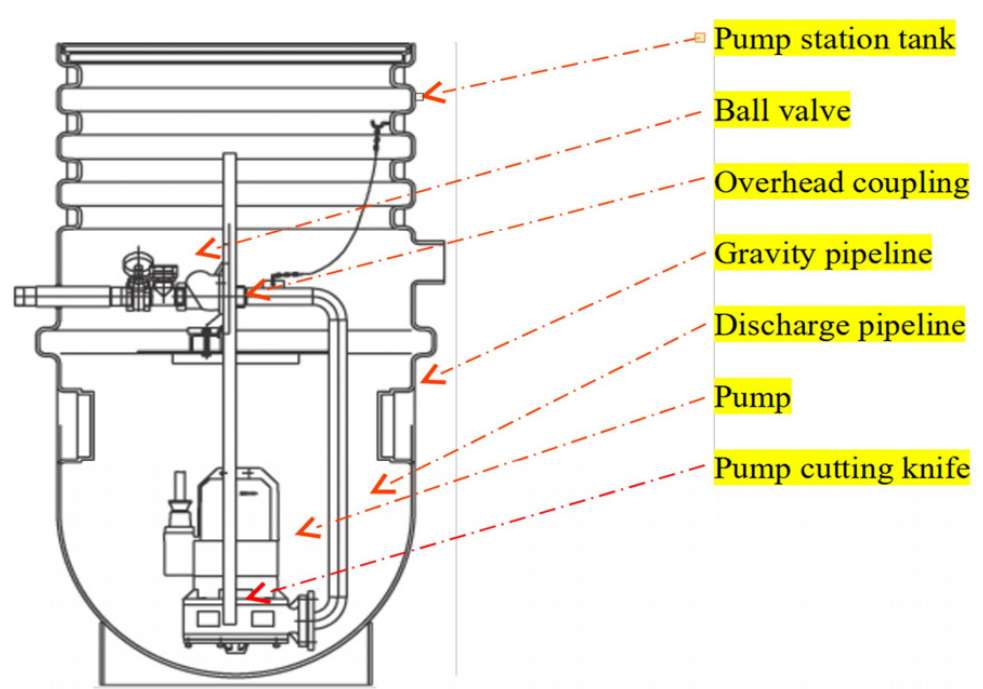
Figure 1. A functioning model of a pumping station.